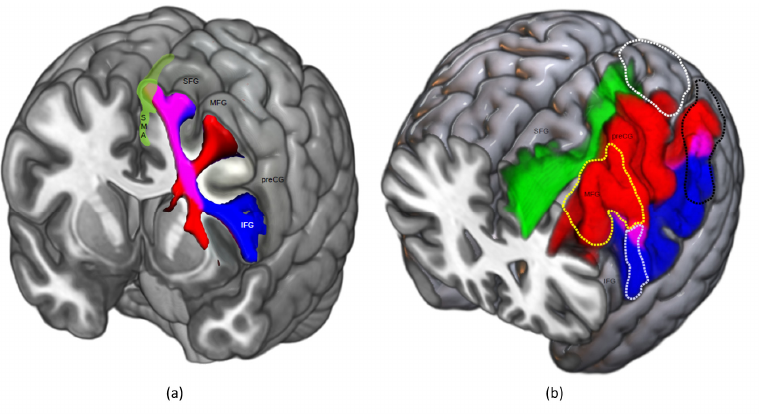
Figure 3. Anatomical relationships between cortical and subcortical structures involved in the second level. ( a ) FAT (blue) and FST (red) trajectories and their cortical projections. The purple zone indicates where these two tracts intermingle. Green area corresponds to the SMA; ( b ) Trajectories and projections of the SLF I (green), SLF II (red) and SLF III (blue). SLF II and III cortical terminations overlapping are show in purple. Posterior part of the dPM (yellow dotted line), vPM (light blue dotted line), superior parietal lobule (white dotted line) and inferior parietal lobule (black dotted line) are also projected to show the relationships between cortical terminations of the SLF I, II and III and fronto-parietal areas involved in motor control. FAT: frontal aslant tract; FST: fronto-striatal tract; SMA: supplementary motor area; SFG: superior frontal gyrus; MFG: middle frontal gyrus; IFG: inferior frontal gyrus; preCG: precentral gyrus; dPM: dorsal premotor cortex; vPM: ventral premotor cortex; SLF: superior longitudinal fascicle.